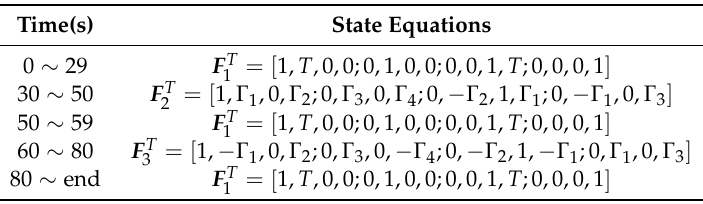
Table 2. Maneuvering process of